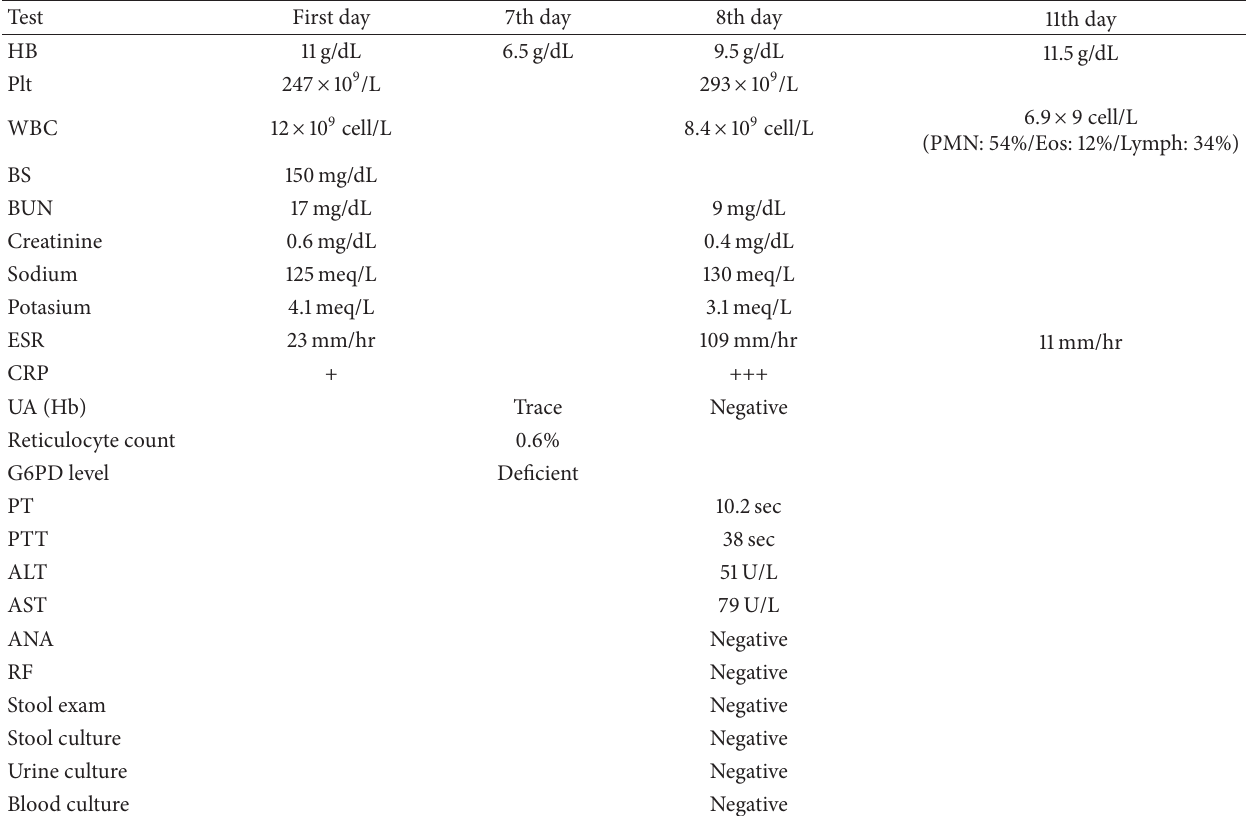
Table 1: Laboratory test results in days 1, 7, 8, and